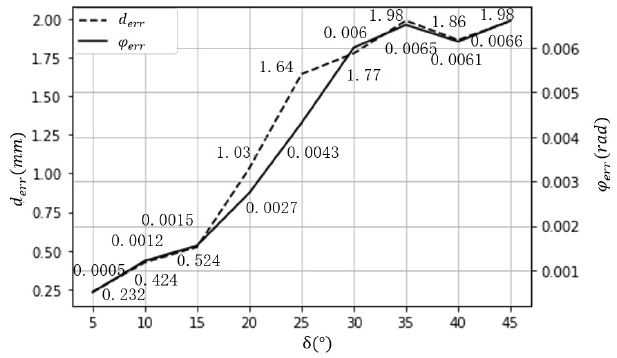
Figure 5. Position and posture errors vs. interval